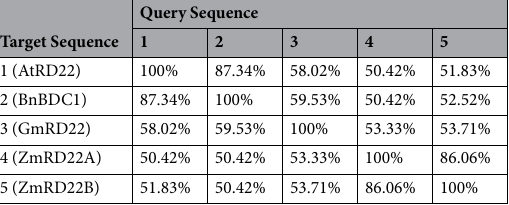
No change was detected in ZmRD22A transcript accumulation in response to the application of ABA (Fig. 3C). However, a 4.5-fold increase in ZmRD22B expression was detected in response to exogenous ABA (Fig. 3D). To confirm the results obtained with semi-qRT-PCR, ZmRD22A and ZmRD22B transcript levels in response to water deficit and ABA treatment were measured using qRT-PCR. Three maize internal control genes, namely